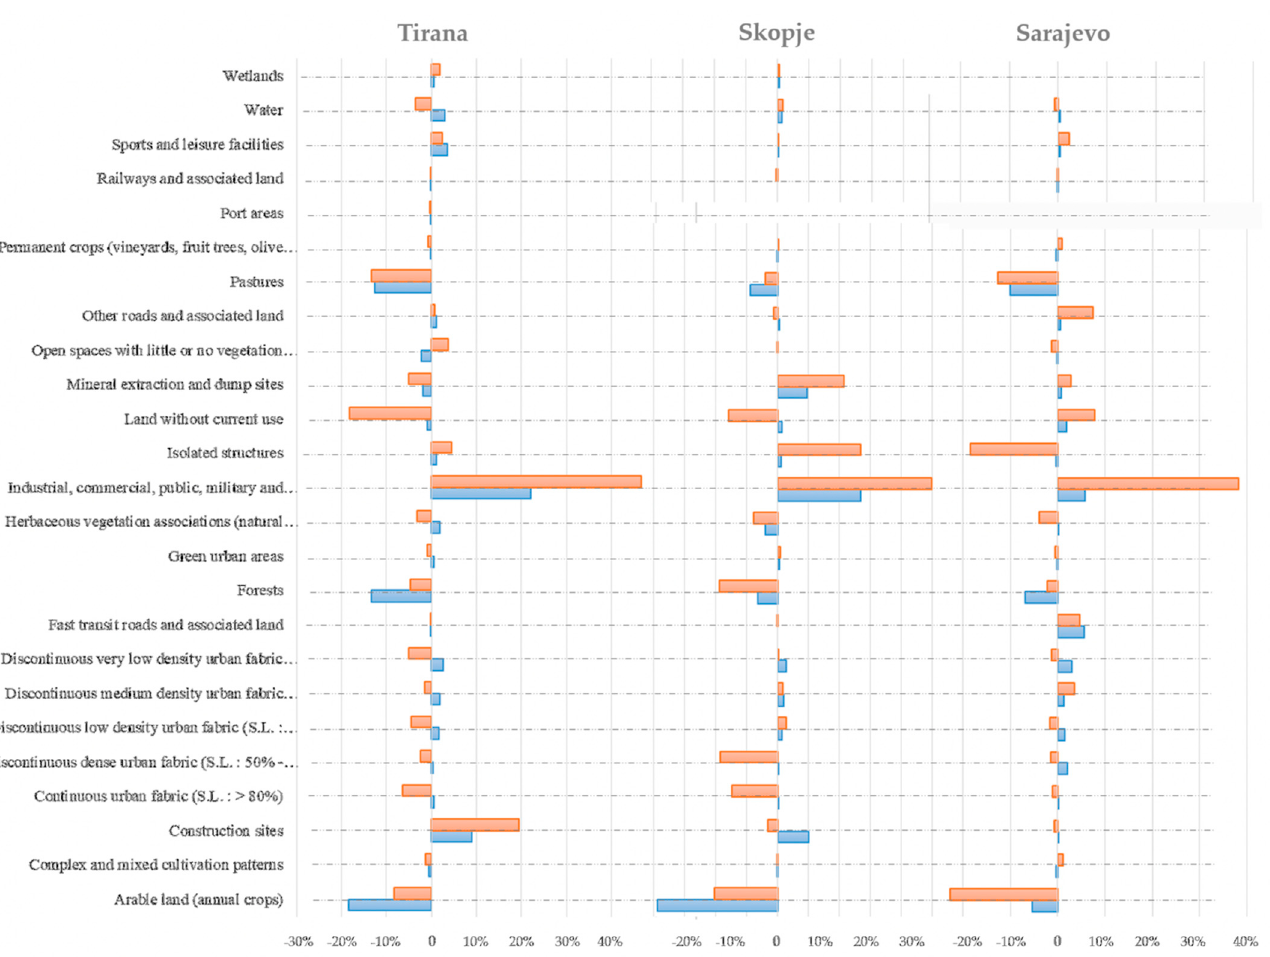
Figure 4. Statistical analysis of difference (2018–2012) count of patches (red) and total area (blue) for Tirana, Skopje, and Sarajevo.